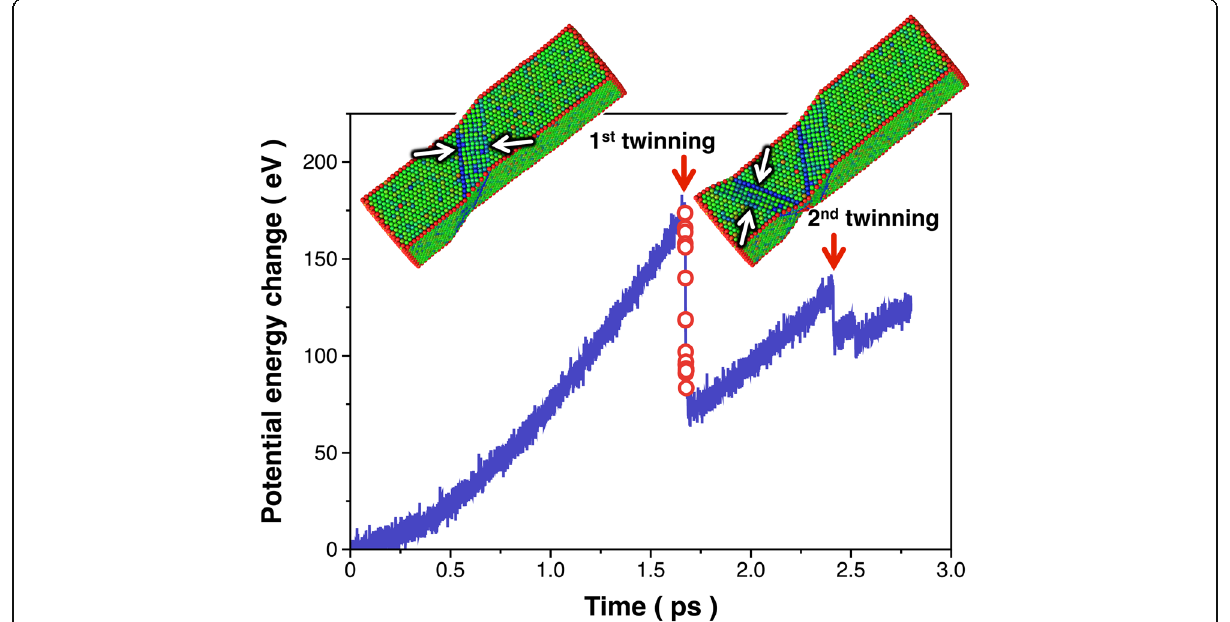
Fig. 4 Changes in the potential energy associated with the formation of twins in the computationally generated Al NW. The potential energy of the Al NW was calculated as a function of the time step, showing a significant drop in the potential energy at times when the twinning events